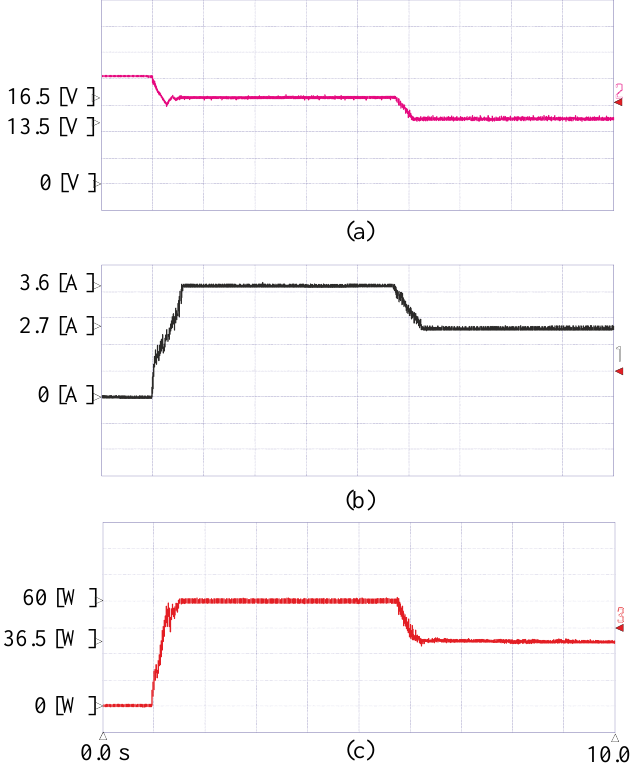
Figure 20. Experimental results of SA-P&O MPPT considering Case 3. ( a ) PV voltage, ( b ) PV current, and ( c ) PV power.